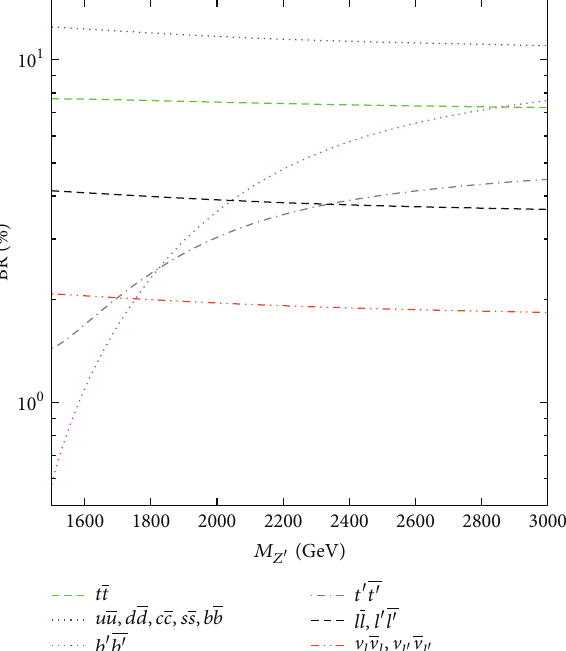
Figure 6: Branching ratios (%) depending on the mass of 𝑍 󸀠 boson for diagonal couplings to quarks and leptons within the 𝑍 󸀠 𝜓 model. Thenewheavyquarkmassesaretakentobe700 GeV,andnewheavy charged lepton mass is 200GeV and new heavy neutrino mass is 100